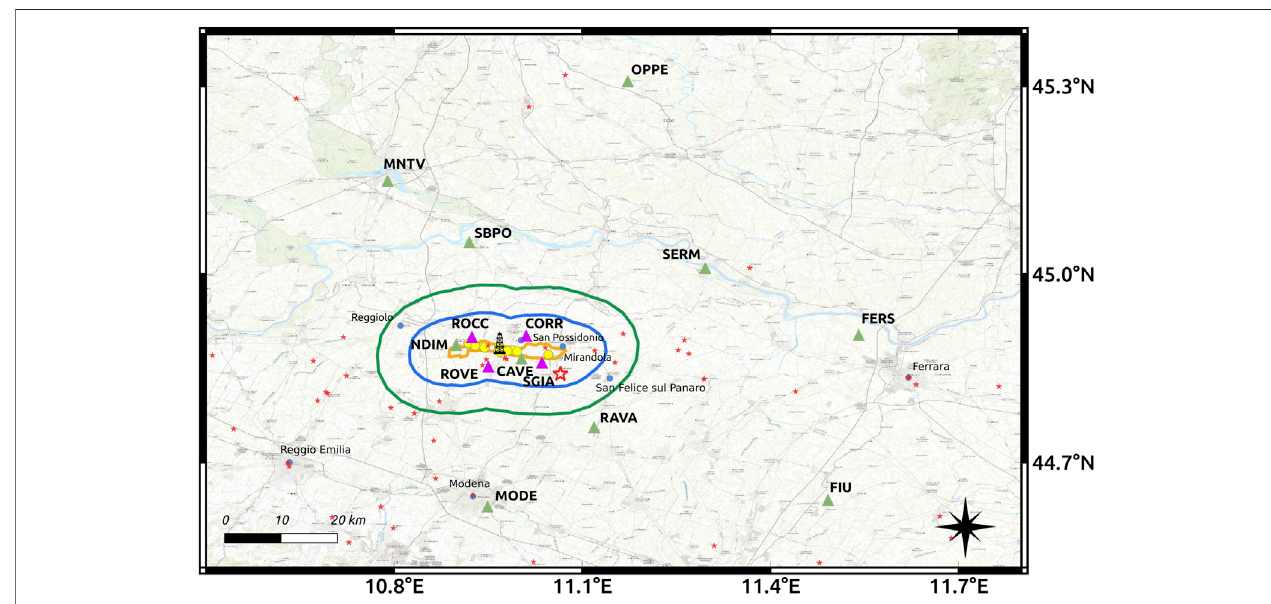
FIGURE2 | Map ofthe Cavone oil fi eldwith local VOseismic stations (purple triangles) and Italian Seismic Network IV station (green triangles) locations. The yellow circles indicate the approximate positions of the extraction wells, while the injection one is sketched in black. The orange line delineates the reservoir projection on the surface.TheblueandgreenlinesarecontouringthedomainsofinterestIDandEDrespectively(seetextformoredetails).Theredstarsshowthelocationsofthehistorical earthquakes with M W ≥ 4.5, occurred in the area, with the bigger one highlighting that on the 29 May, 2012, as from Rovida et al. (2020).